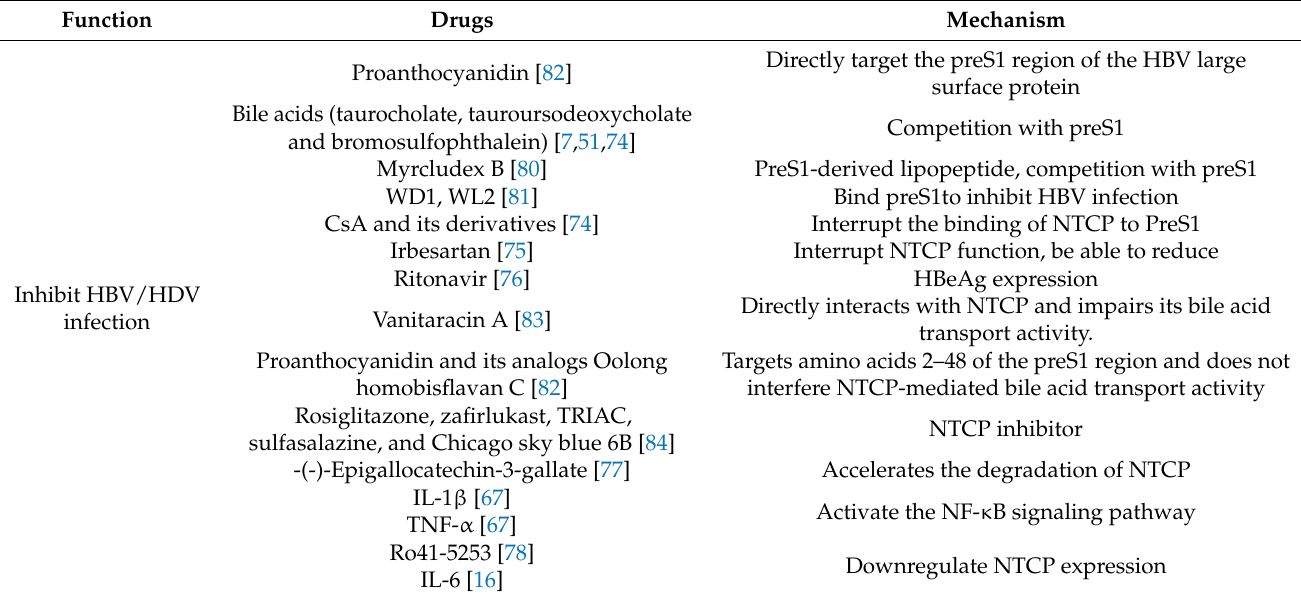
Table 2. Drugs that target NTCP to treat